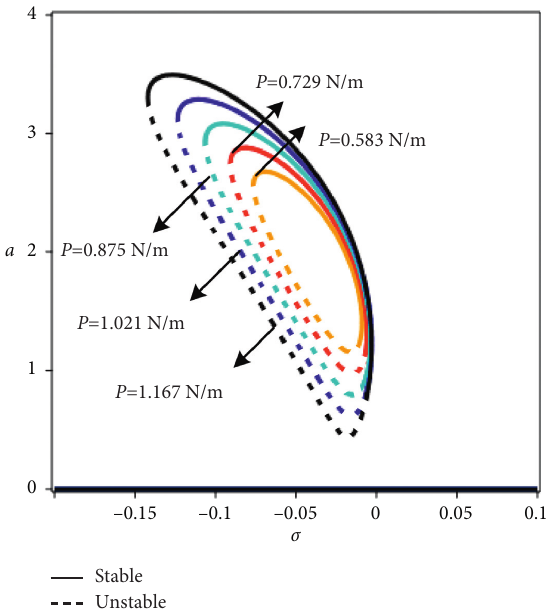
Figure 14: The 1/3-order subharmonic amplitude-frequency re- sponse curve (varied P ).